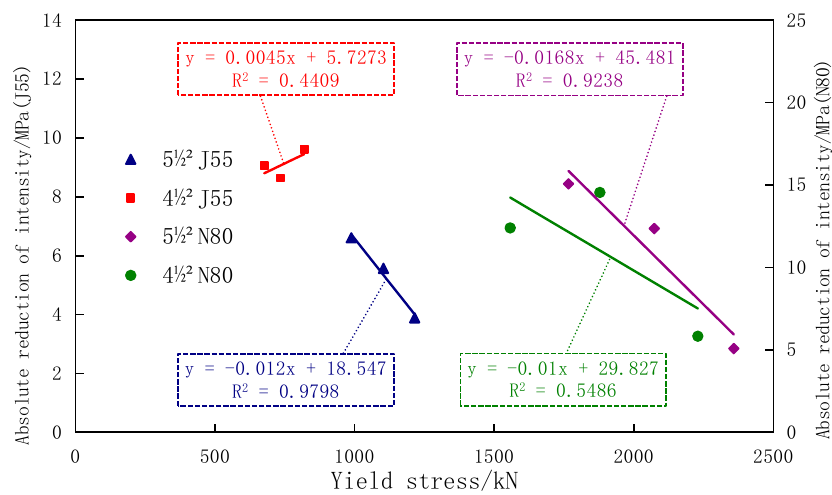
Figure 18. Relationship between relative intensity-reduction ratio and yield stress.